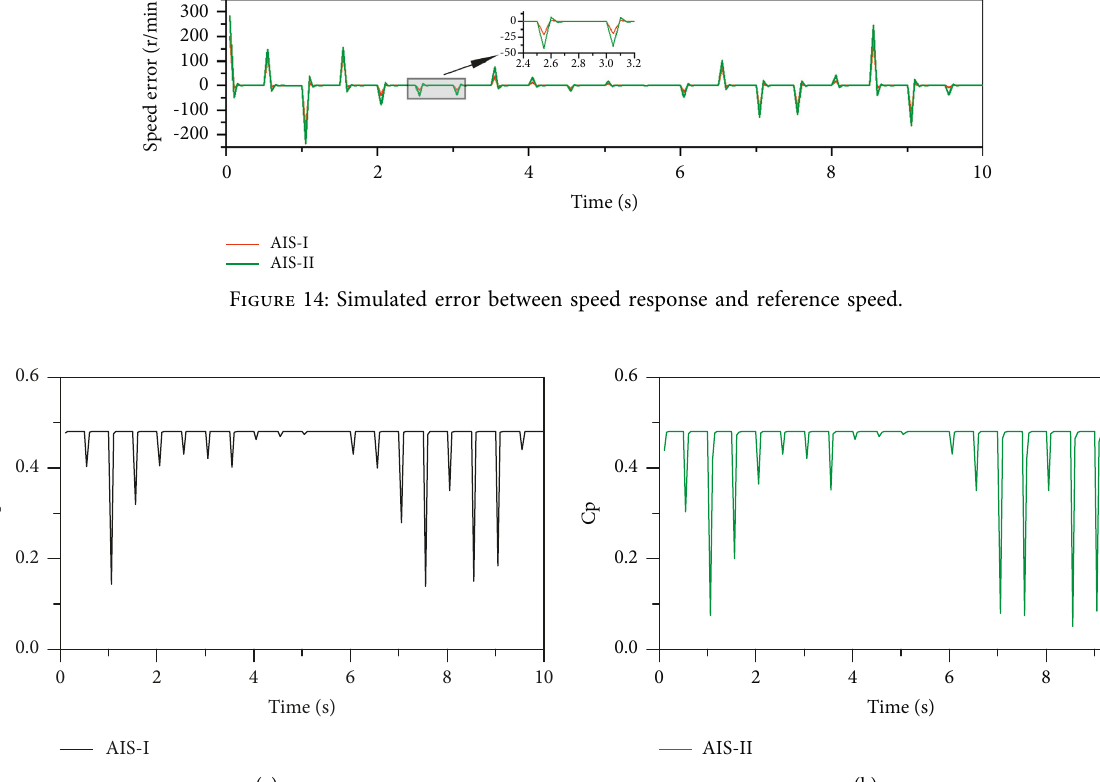
C p based on the AIS-I method and (b)